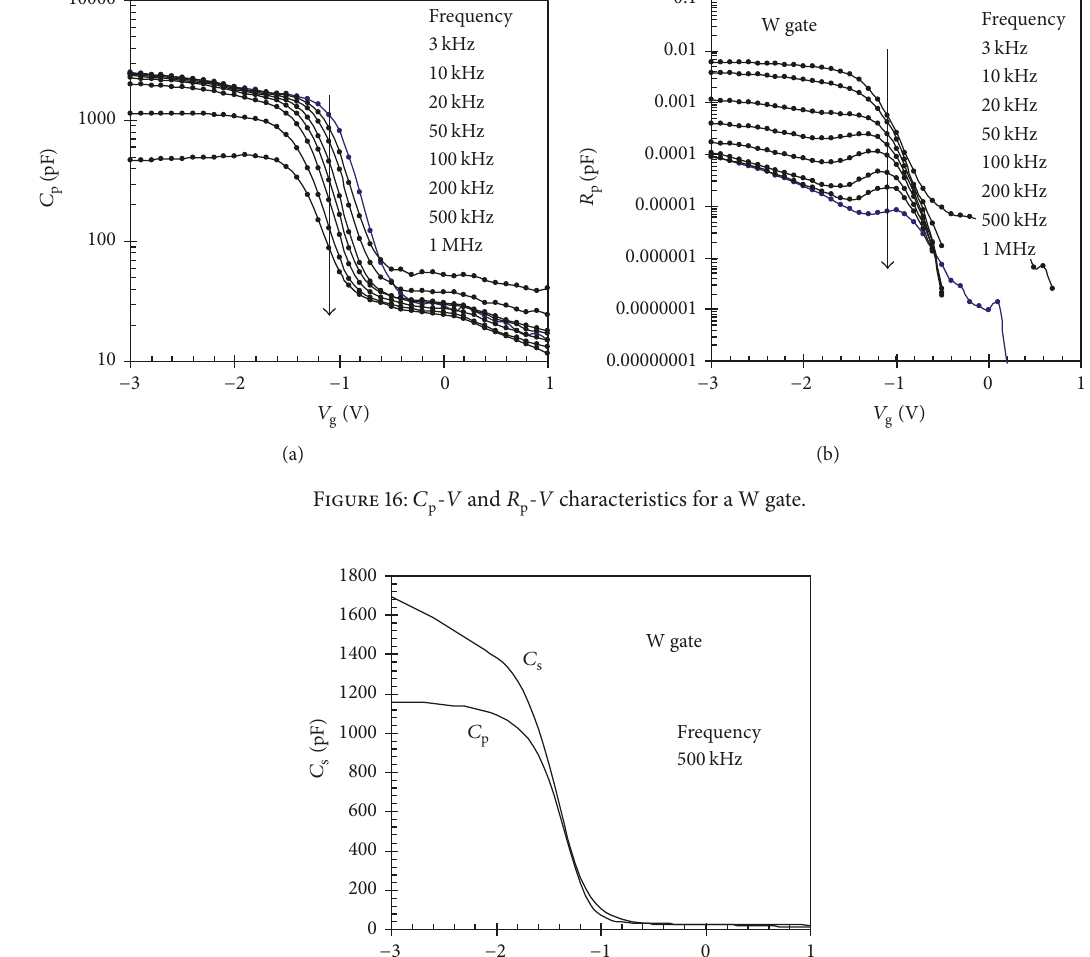
Figure 17: Comparison of 𝐶